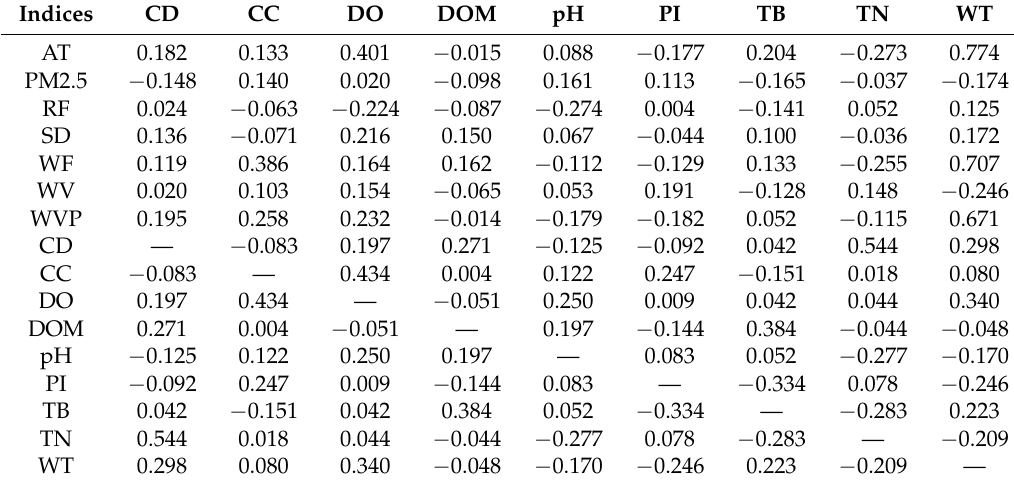
Table 3. Correlation coefficients between two different indicators.